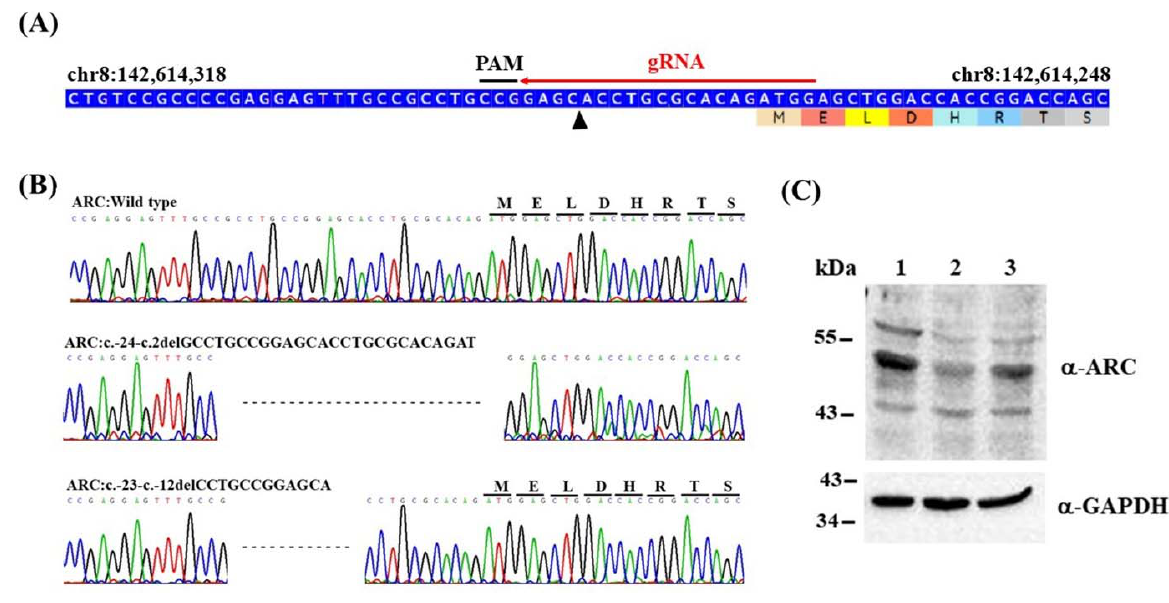
Figure 1. Generation and characterization of ARC -KO HEK293 cell lines: ( A ) Schema of the guide RNA target site of ARC . Arrowhead indicates the predicted double-strand break site: PAM, protospacer adjacent motif. ( B ) Sanger sequencing analysis of edited cell lines. ( C ) Representative immunoblots of ARC protein in wild-type (1) and edited (2: c.-24- c.2delGCCTGCCGGAGCACCTGCGCACAGAT; 3: c.-23-c.-12delCCTGCCGGAGCA) cells. GAPDH was used as the loading control. Table 1. Top five GO terms enriched in ARC -KO-related DEGs.